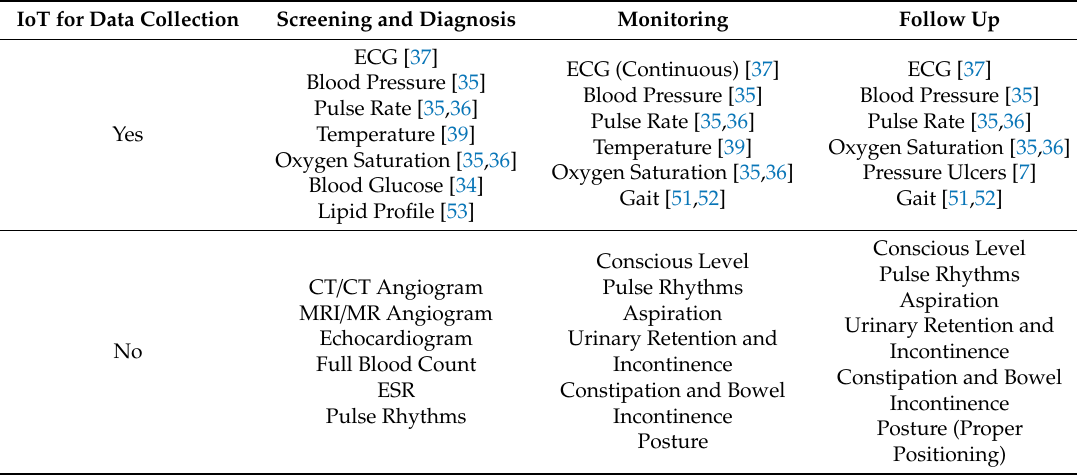
Table 4. Required data and IoT availability for